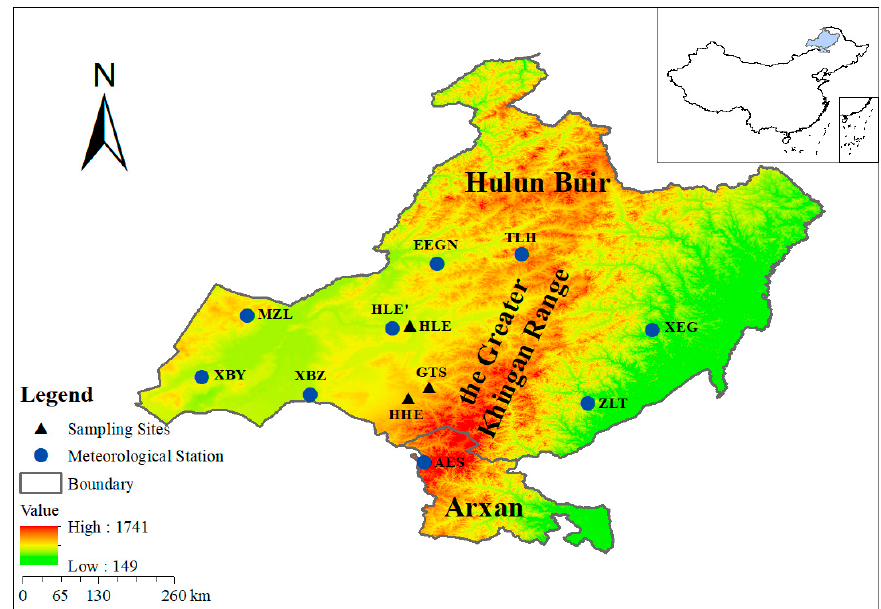
Figure 1. Location of the sampling sites and meteorological stations (sampling site: HLE, Haila’er; GTS, Guangtoushan; HHF, Huihe Forestry; meteorological station, XBY, Xinbalhoo Youqi; XBZ, Xinbalhoo Zuoqi; MZL, Manzhouli; EEGN, Eerguna; TLH, Tulihe; XEG, Xiaoergou; ZLT, Zhalantun; AES, Aershan).